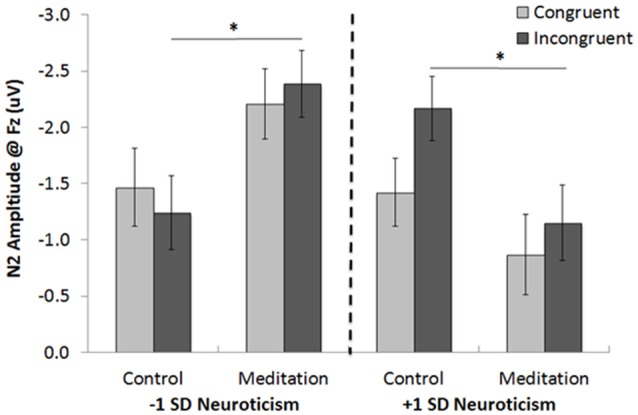
The 3-way interaction between neuroticism, meditation/control tape condition and trial type in Study 2 on N2 amplitudes at Fz (Note: negativity is plotted up for ease of interpretation; higher N2 amplitudes will thus be presented as taller bars). *p < 0.05.